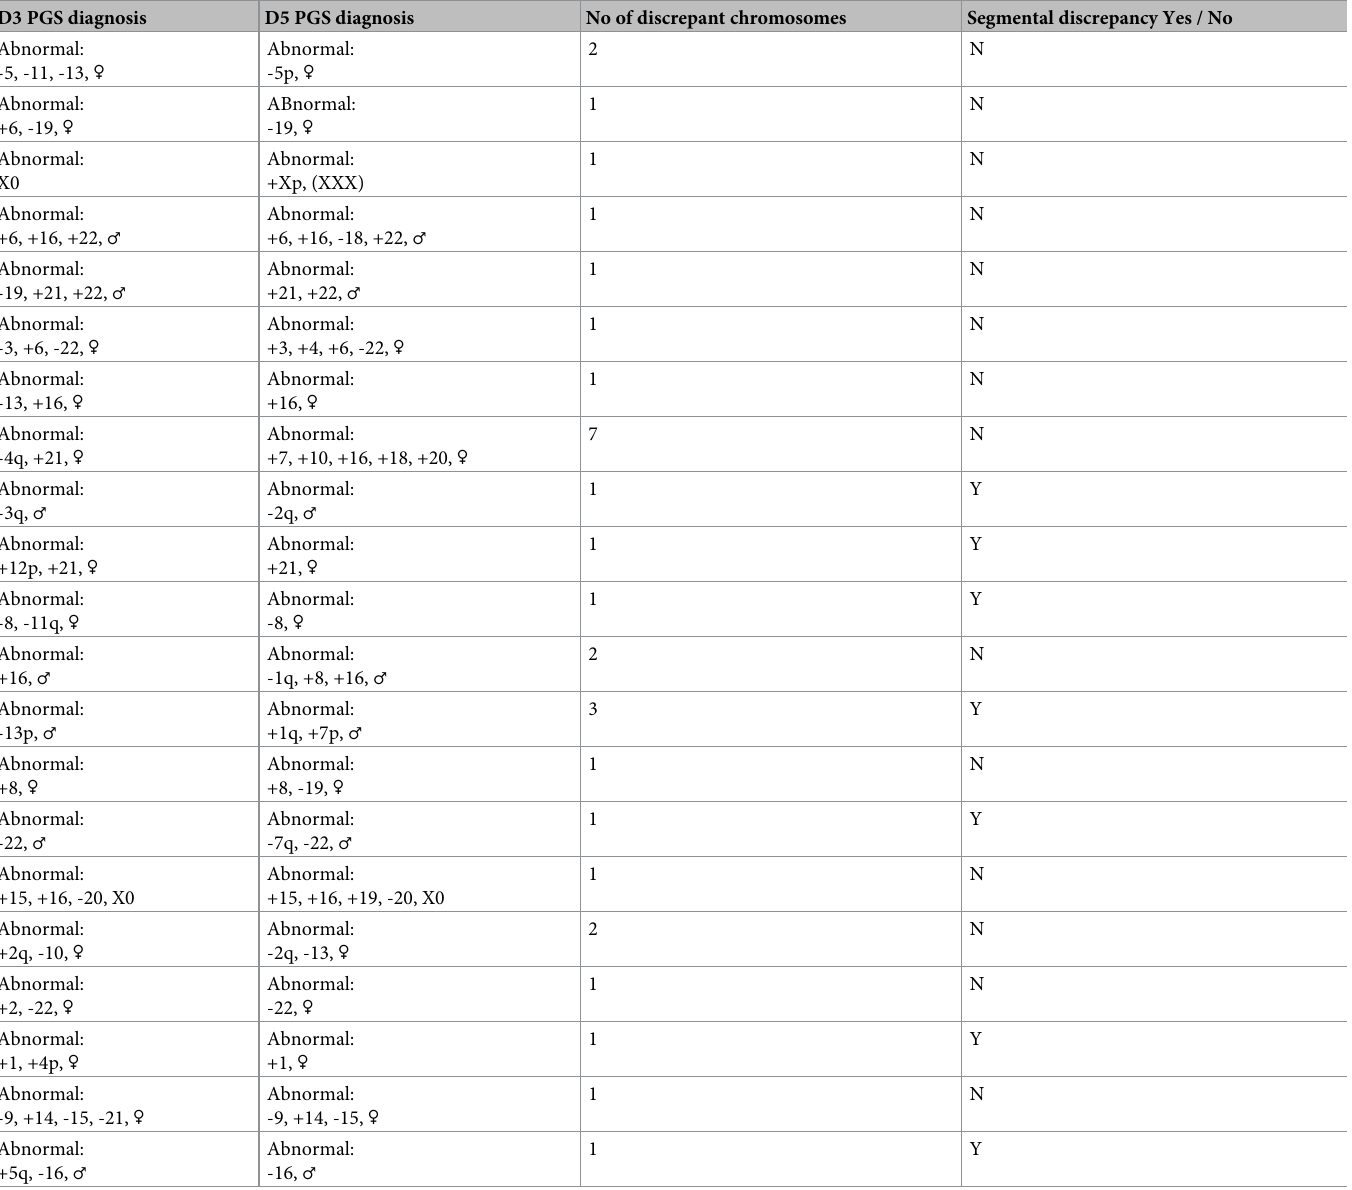
Table 5. Discordance-rate per chromosome (Aneuploid D3-Aneuploid D5). D3 PGS diagnosis D5 PGS diagnosis No of discrepant